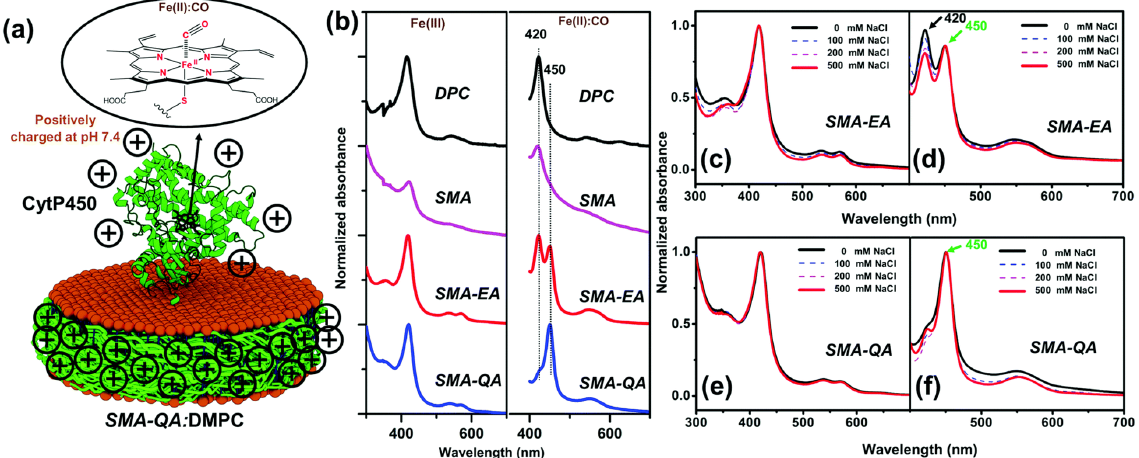
Figure 11. Reconstitution and functional characterization of CYP450 2B4 in differently charged polymer-nanodiscs and DPC micelles: ( a ) Schematic showing CYP450 with heme coordination spheres of the CO-bound state reconstituted in an SMA-QA:DMPC nanodisc. ( b ) UV-vis absorption spectra of CYP450 reconstituted in different SMA polymer-nanodiscs or in DPC micelles in its ferric state (left column) and in a ferrous state in complex with CO (right column). UV-vis absorption spectra of a positively-charged CYP450 reconstituted in negatively-charged SMA-EA nanodiscs: ( c ) in the presence of the indicated NaCl concentrations and ( d ) the ferrous-CO complex ( d ). UV-vis spectra of a positively-charged CYP450 reconstituted in positively-charged SMA-QA-based DMPC nanodiscs and ( e ) in the presence of NaCl and ( f ) the ferrous-CO complex. These results demonstrate the importance of a membrane mimetic and polymer charge in nanodisc for the functional reconstitution of membrane proteins. The inactive CYP450 (i.e., P420) in the presence of DPC detergent or an anionic-polymer (like SMA or SMA-EA) is undesirable. The positively-charged SMA-QA retains the functional form of CYP450. This Figure and caption are adopted from reference